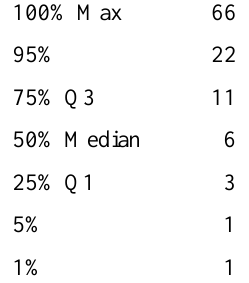
Table 4: Distribution of elderly CSS Table 5: Quantiles of the distribution of enrollees who died after individuals with any 2003 12/31/2003, by year of death cardiovascular drug pre- scriptions, by number of 2003 cardiovascular drug pre- Percent of total Year of death Frequency scriptions